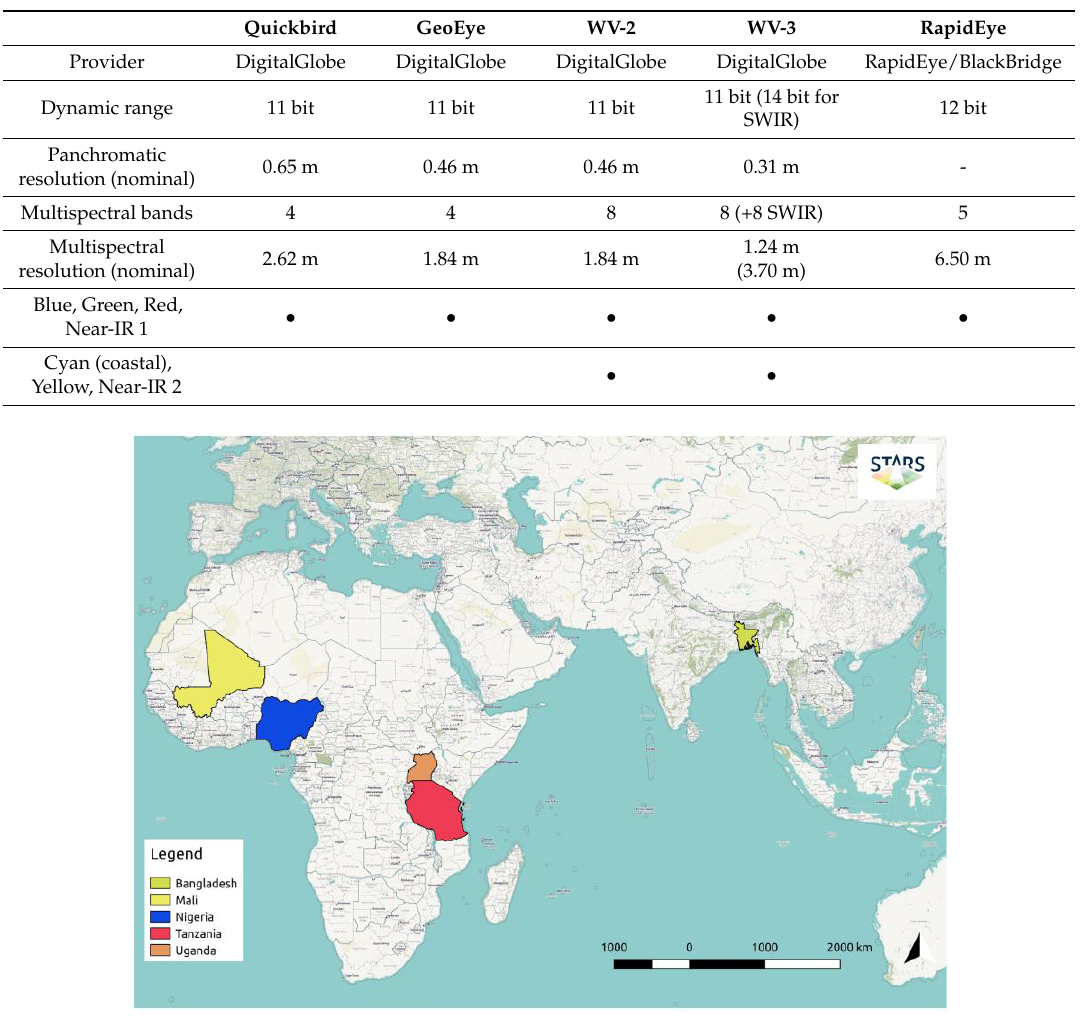
Figure 2. Areas of study in Southeast Asia and sub-Saharan Africa for which VHSR satellite images were acquired and on which the Spurring a Transformation for Agriculture through Remote Sensing (STARS) workflow has been tested. In Mali and Nigeria, over 150 fields of various crops were monitored to examine the ways in which the data can be used to the benefit of the local farming communities. In Tanzania and Uganda, four separate large blocks of croplands were monitored to provide data to the National Food Security office to more accurately forecast crop yields. In Bangladesh, the floodplains of the southern delta were studied to establish irrigation systems that enable farmers to grow a second crop during the dry season.